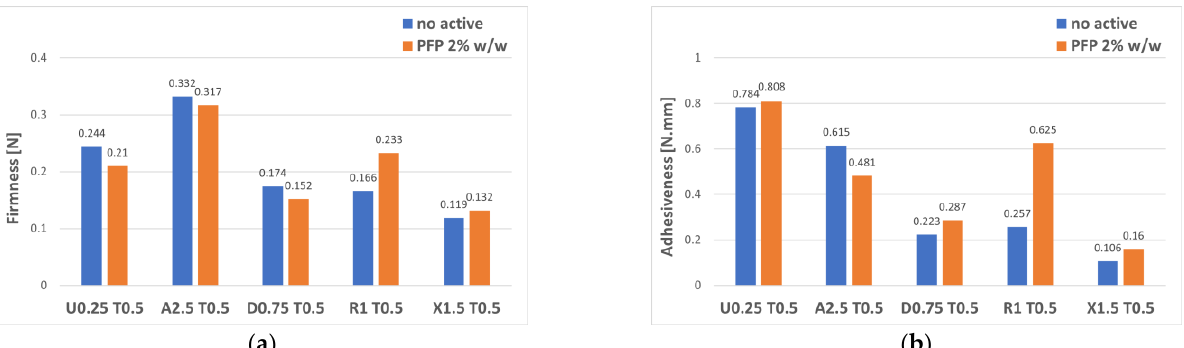
Figure 3. Comparison between the texture parameters measured before and after adding 2% w / w of PFP for the gels U0.25T0.5 prepared with U at 0.25% w / w and T at 0.5%, A2.5T0.5 prepared with A at 2.5% w / w and T at 0.5% w / w , D0.75T0.5 prepared with D at 0.75% w / w and T at 0.5% w / w , R1T0.5 prepared with R at 1% w / w and T at 0.5% w / w , X1.5T0.5 prepared with X at 1.5% w / w and T at 0.5%